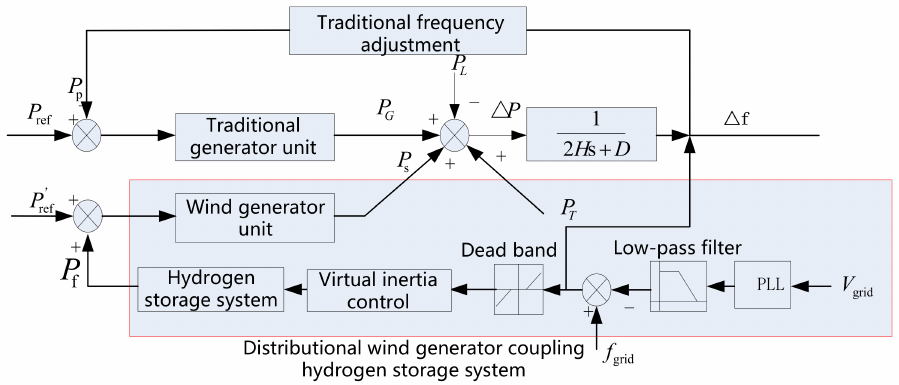
Figure 2. Virtual inertial control model containing the hydrogen storage